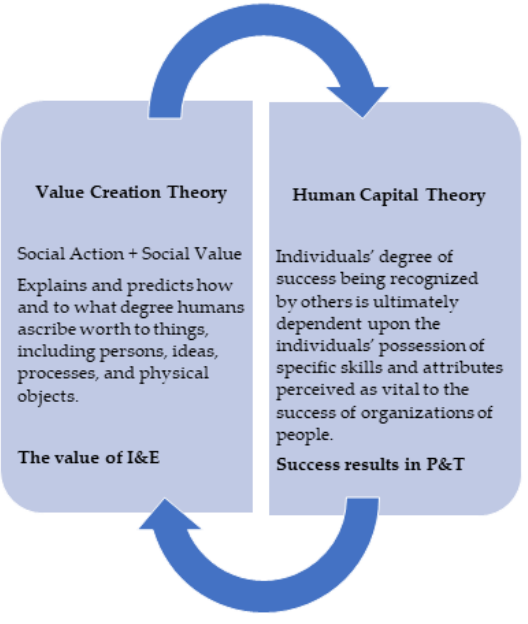
Figure 1. The relationship between value creation theory [79] and human capital theory [81] consid- ering research interests.